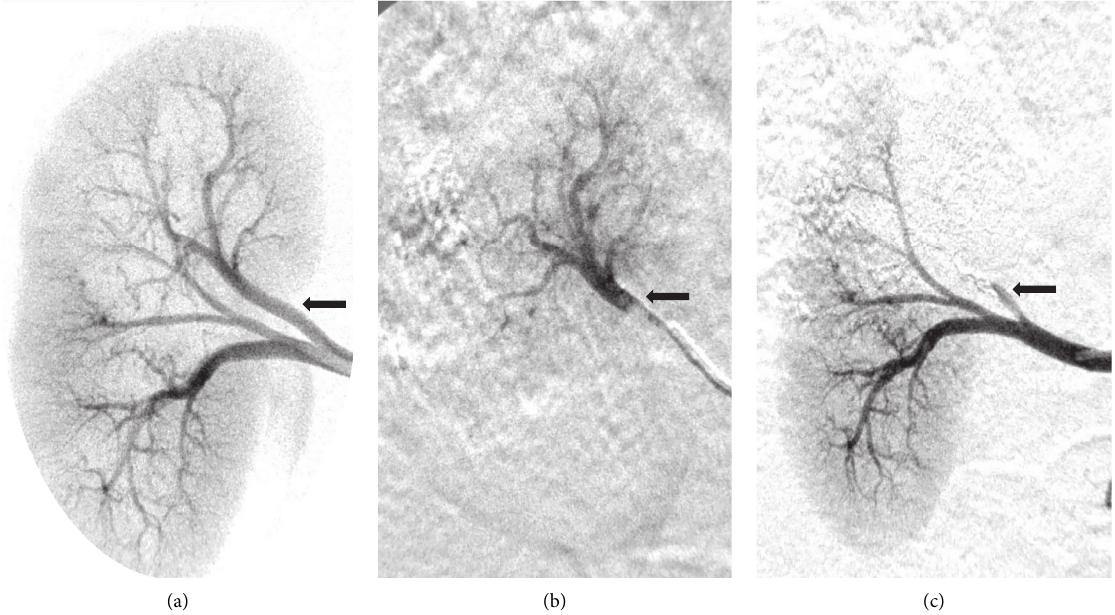
Figure 2: Example of right kidney DSA during embolization procedure: before (a), during (b), and after (c) embolization with AS18. Black arrows correspond to the target